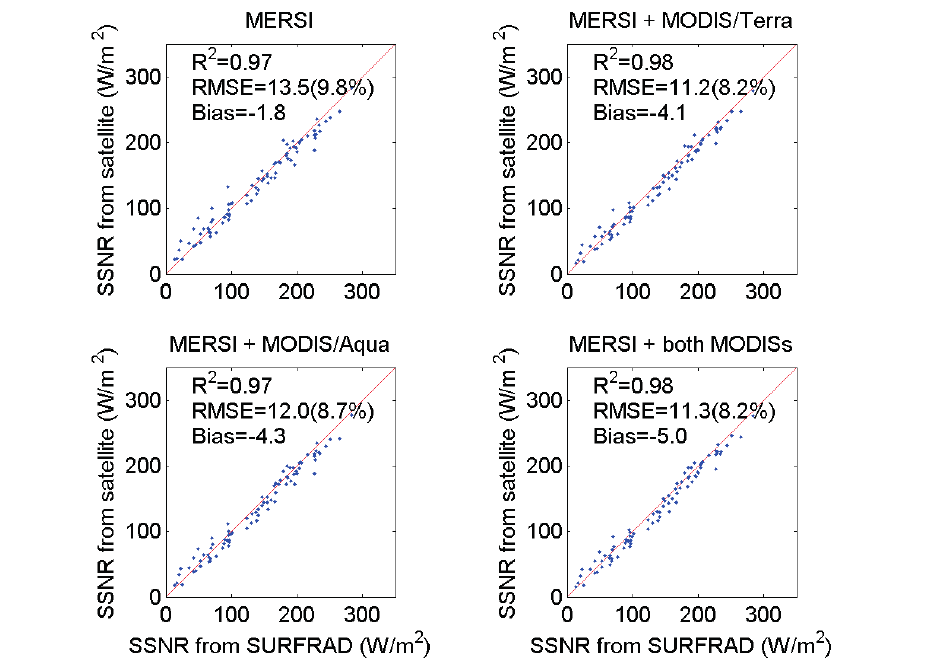
Figure 7. Scatter plot between monthly SSNR measured at SURFRAD stations and retrieved from satellite data and aggregated to a spatial resolution of 161